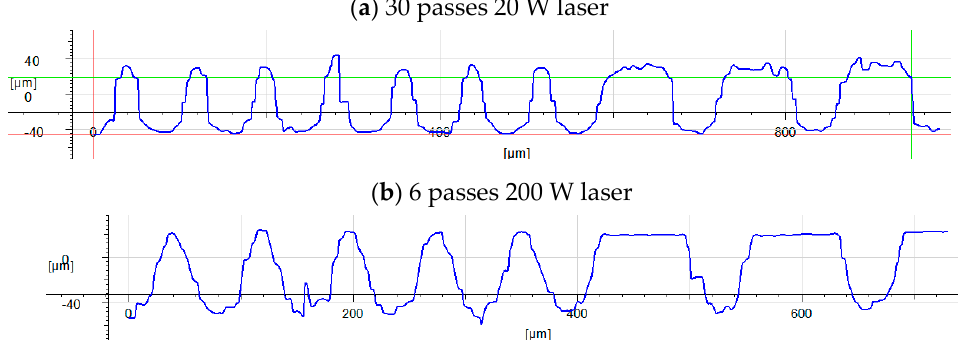
Figure 8. Cross-section surface profile of topographies achieved by the 20 W laser ( a ) and 200 W laser ( b ).